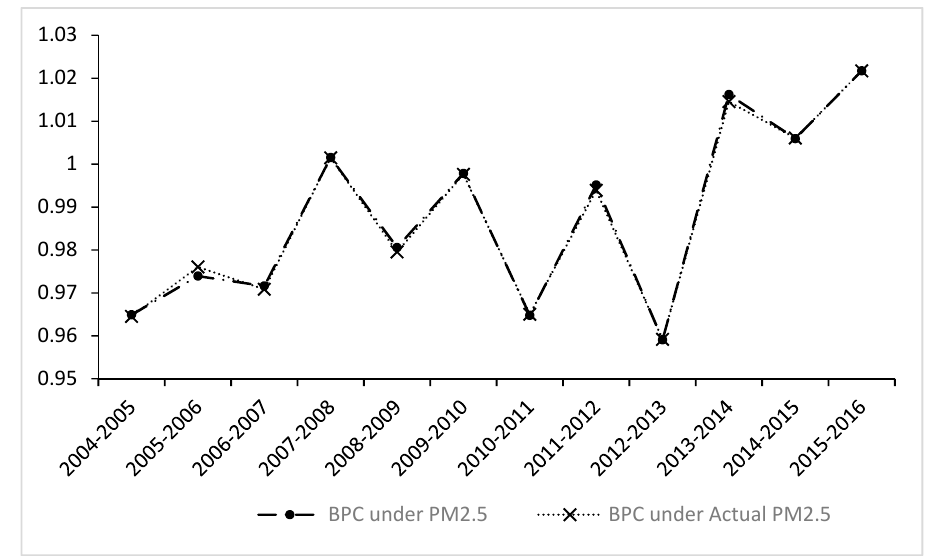
Figure 2. The dynamic trend of efficiency change (EC) index under PM 2.5 (diameter of fine particulate matter less than 2.5 μ m) and actual PM 2.5 .